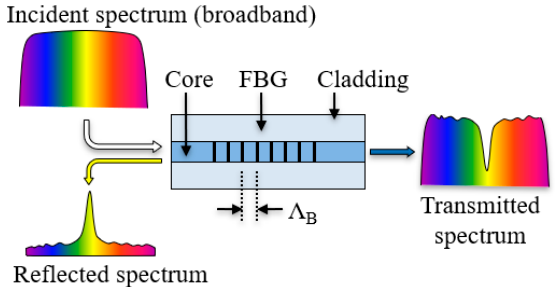
Figure 2. Illustration of reflection of fiber Bragg gratings (FBG).